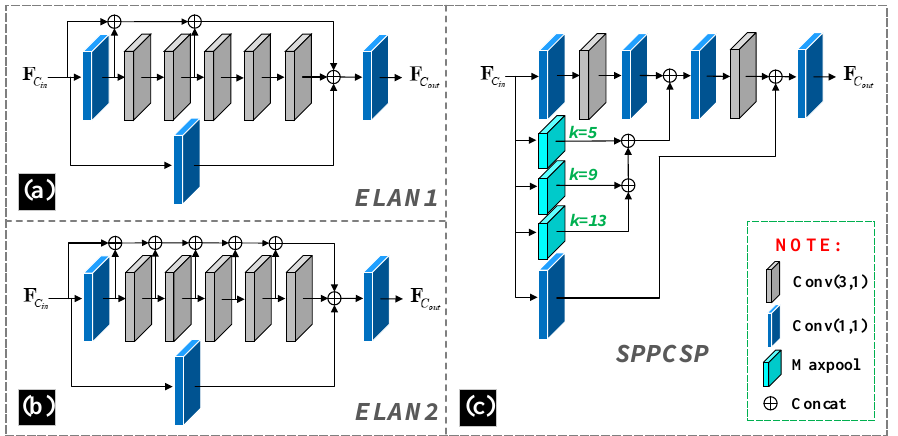
Figure 2. Structures of the feature extraction modules in the backbone and neck. Where ( a ) is the structure of ELAN1, ( b ) is the structure of ELAN2, and ( c ) is the structure of SPPCSP. These structures remain consistent with the design in YOLOv7, where ELAN2 has essentially the same essential components as ELAN1, but ELAN2 has more channels than ELAN1 in the feature aggregation part to ensure that multi-scale feature information is aggregated in the neck. For the maxpool structure in SPPCSP, the value of k is the ratio of